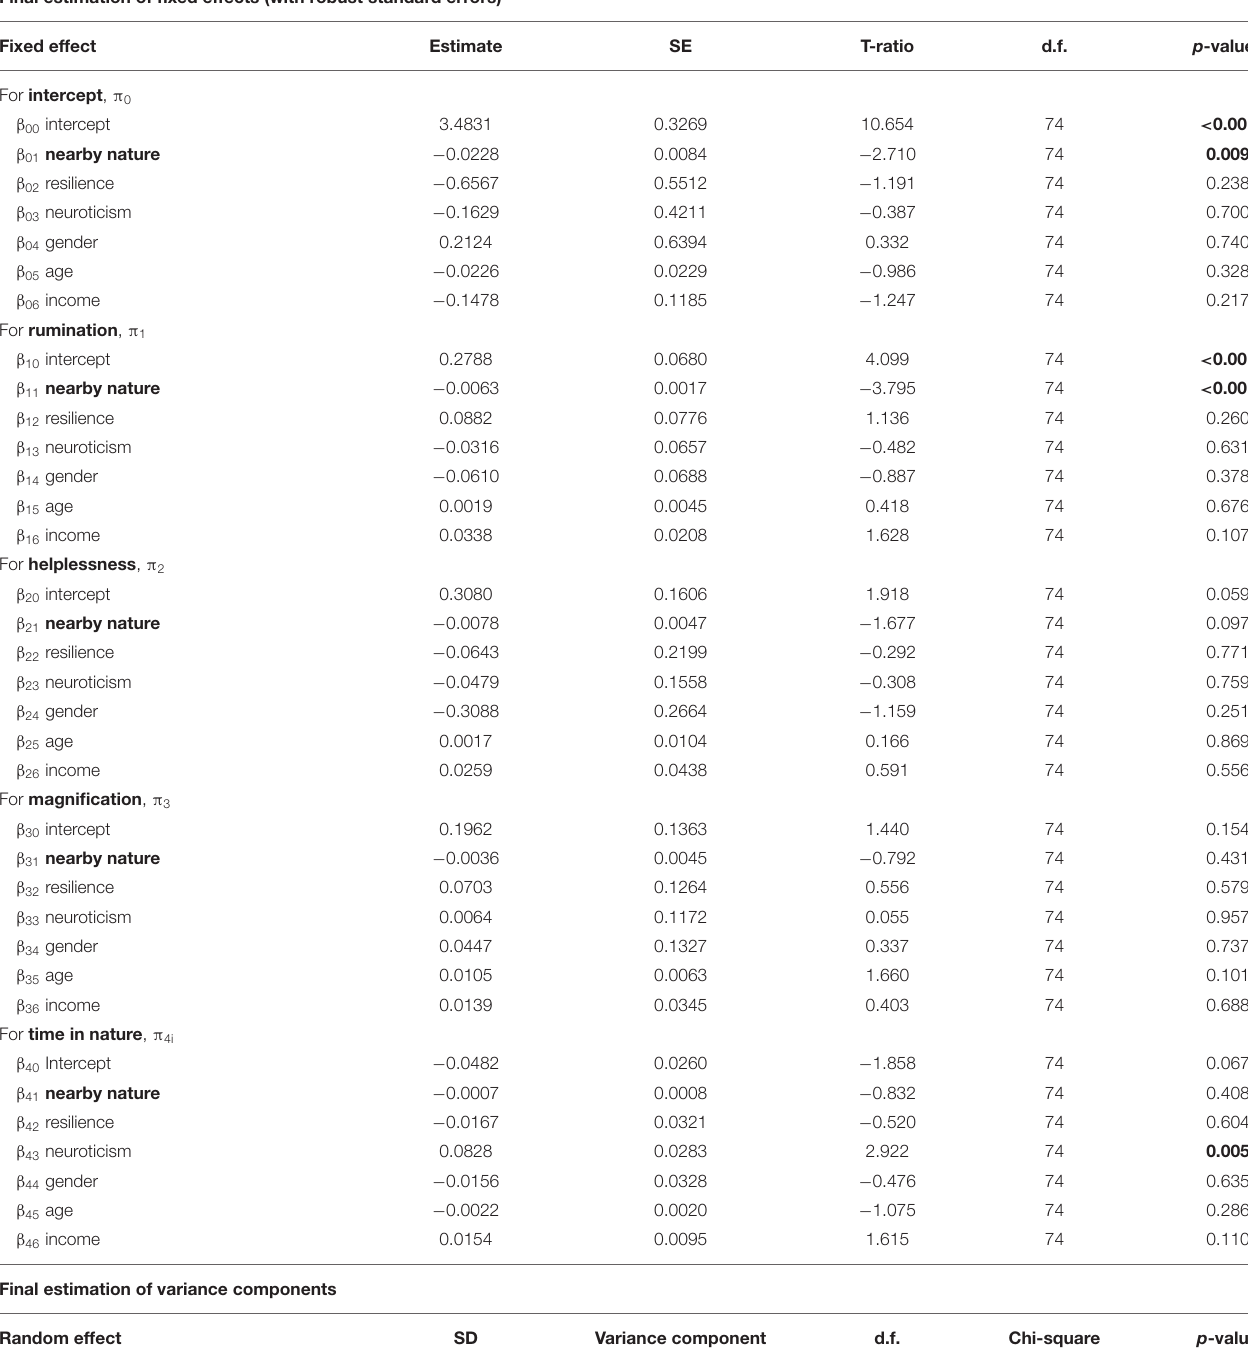
TABLE 3 | RQ2: Multilevel regression predicting daily pain intensity including rumination, magnification, helplessness. Final estimation of fixed effects (with robust standard